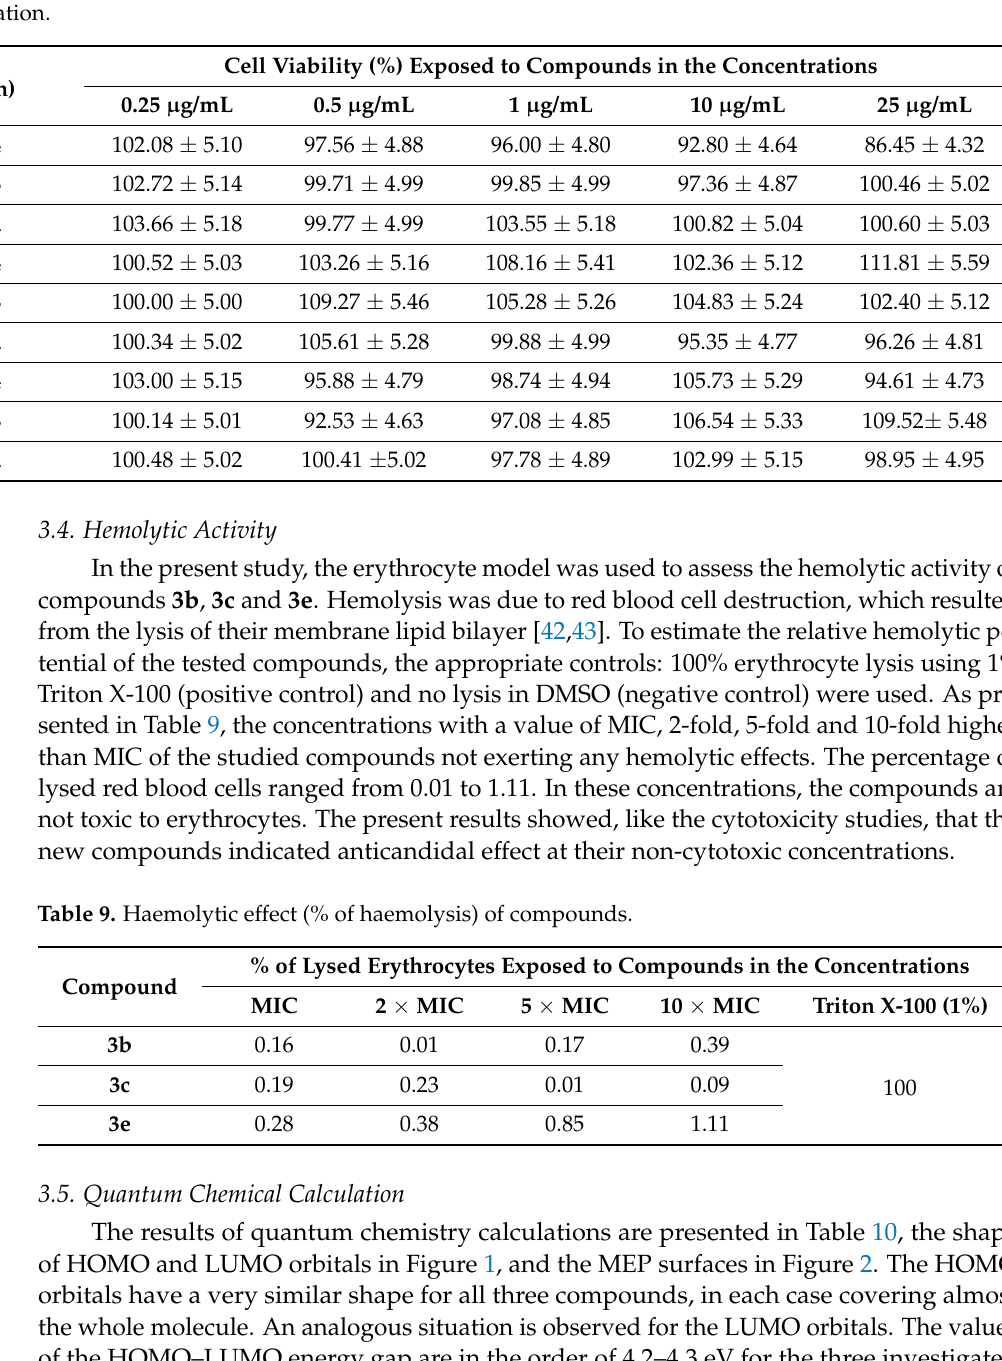
Table 8. Viability (%) of normal human lung fibroblasts (CCD-11Lu) cell exposed to the tested compounds expressed as means ± standard deviation.